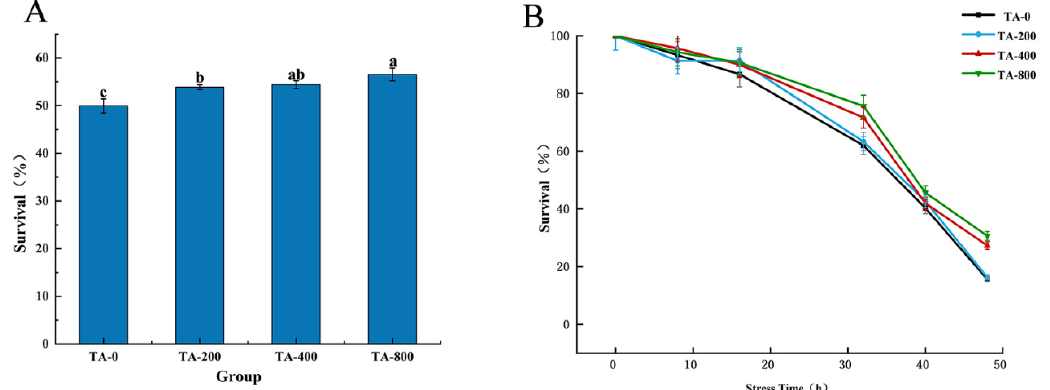
Mean values ± SD ( n = 3). Identical values in same row with a similar superscript are no longer substantially exclusive ( p > 0.05) by the Duncan test. Where IW = initial weight, FW = final weight, WGR = weight gain rate, FCR = feed conversion ratio.